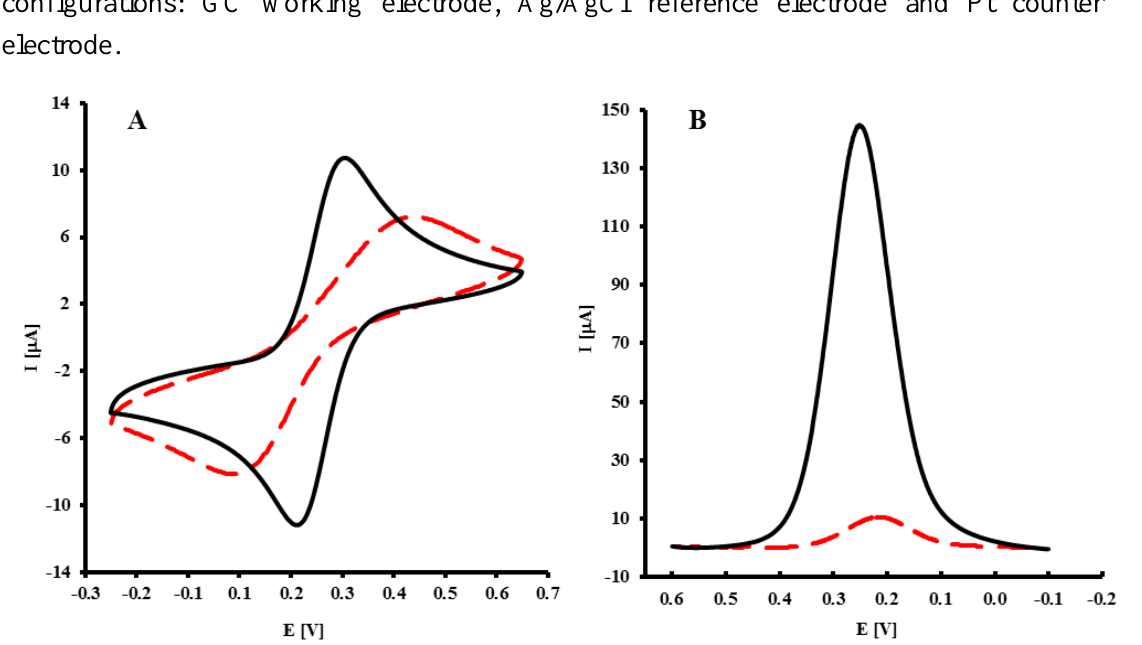
Figure 2. ( A ) Cyclic voltammograms (scan rate 0.1 V/s) and ( B ) square